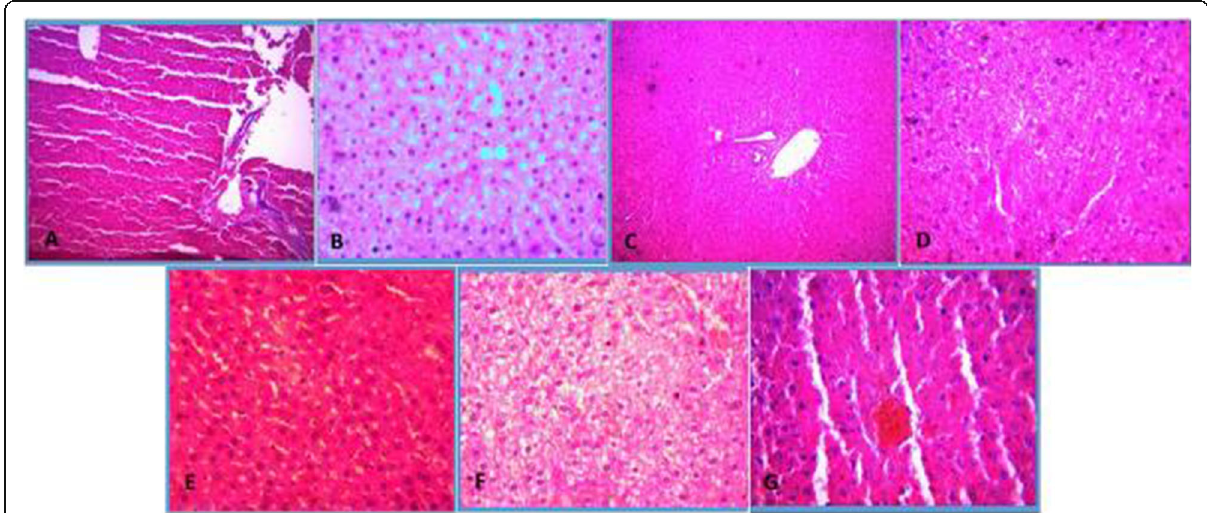
Fig. 3 Photomicrograph slides of rat liver (Hematoxylin and eosin staining, 100x magnification). A: Liver of Diabetic control; B: Liver of Obese